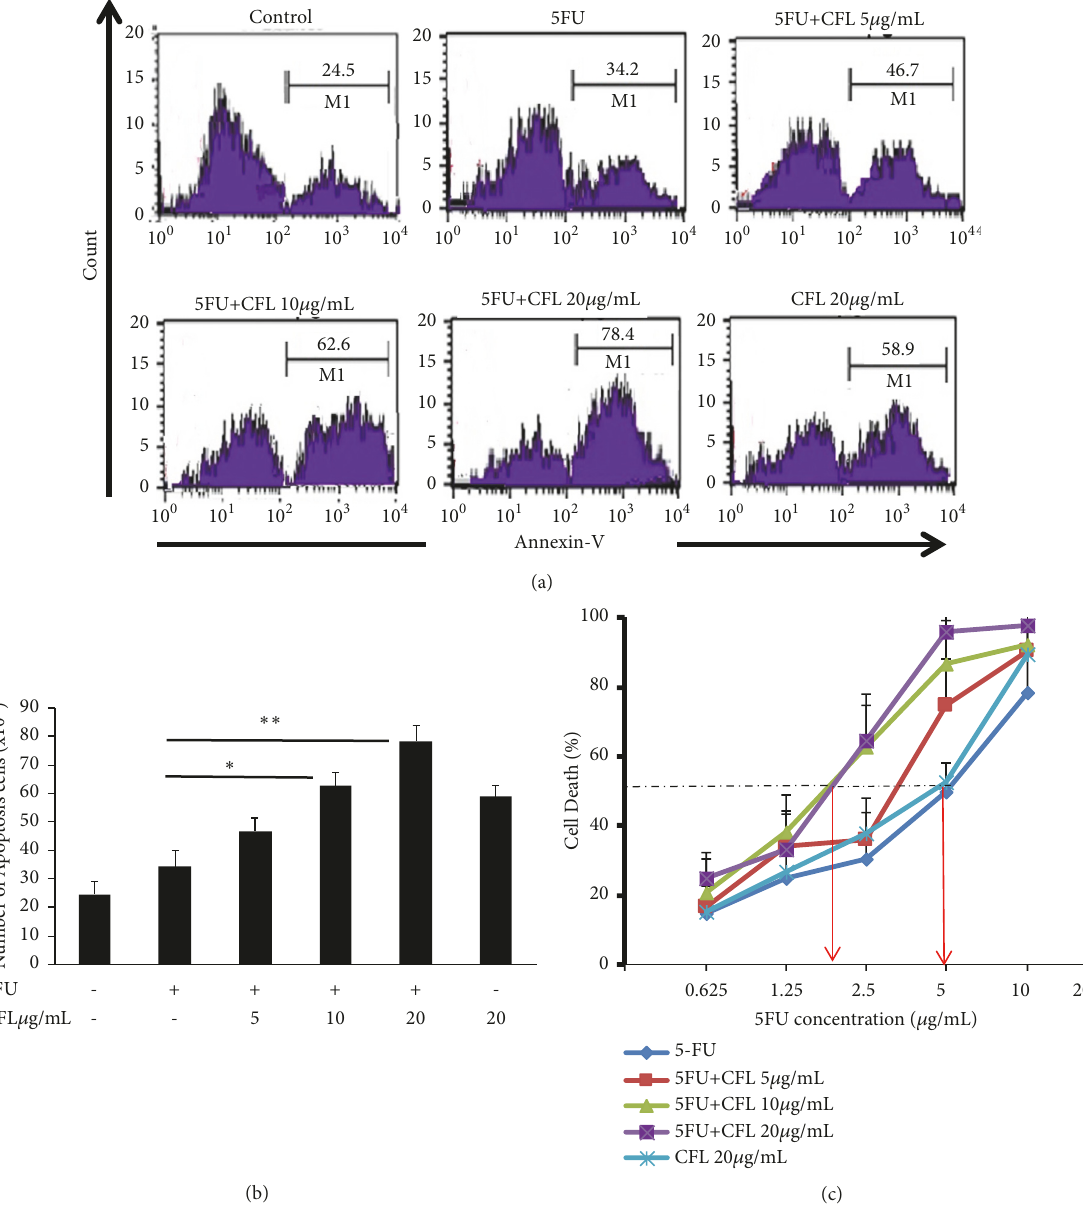
Figure 1: The combination therapy of CFL with 5-fluorouracil induced apoptosis in HT-29 cell line . (a) HT-29 cell line was cultured and divided into six groups: group 1 was without treatment (control); group 2 was treated with 5-fluorouracil, groups 3-5 were treated with either CFL 5, 10, or 20 𝜇 g/ml immediately after 5- fluorouracil, and group 6 was treated with CFL 20 𝜇 g/ml. The number of apoptosis cells showed thatcombinationtreatmenthashighernumberthansingletreatmentgroup,respectively(p < 0.05;p < 0.05;p < 0.05).Redlines(isotypecontrol). (b)Numberof annexin-Vpositive cellsindicatedapoptosis cells. (c).Dose response of CFL showed cytotoxicsynergistic effects(results shown are mean ± SD, with n =4 ∗ p < 0.05, ∗∗ p <